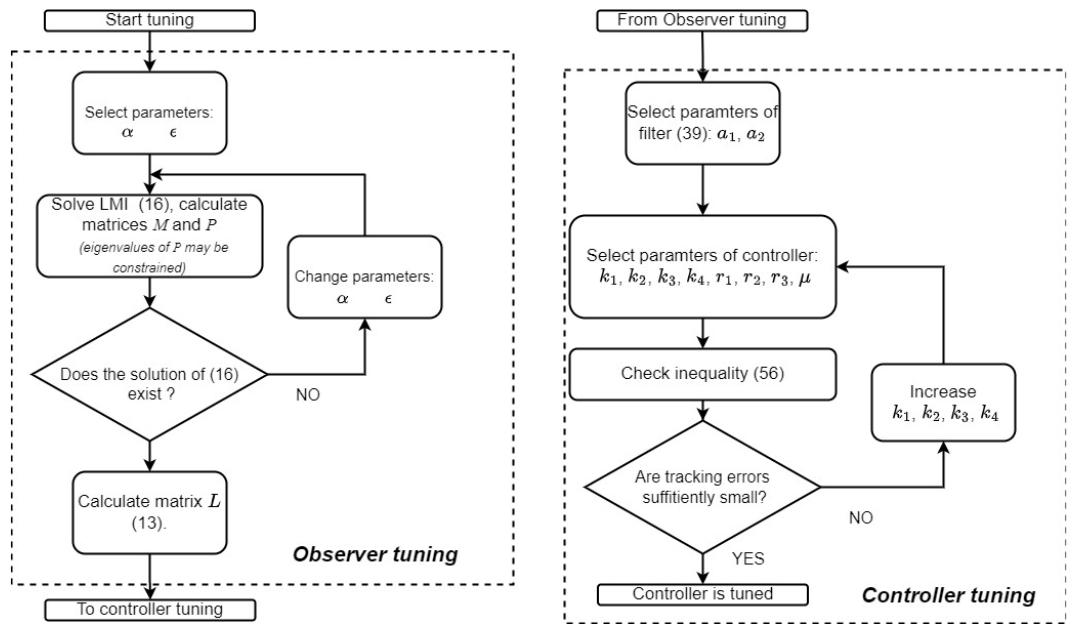
Figure 3. The procedure for tuning the controller parameters.